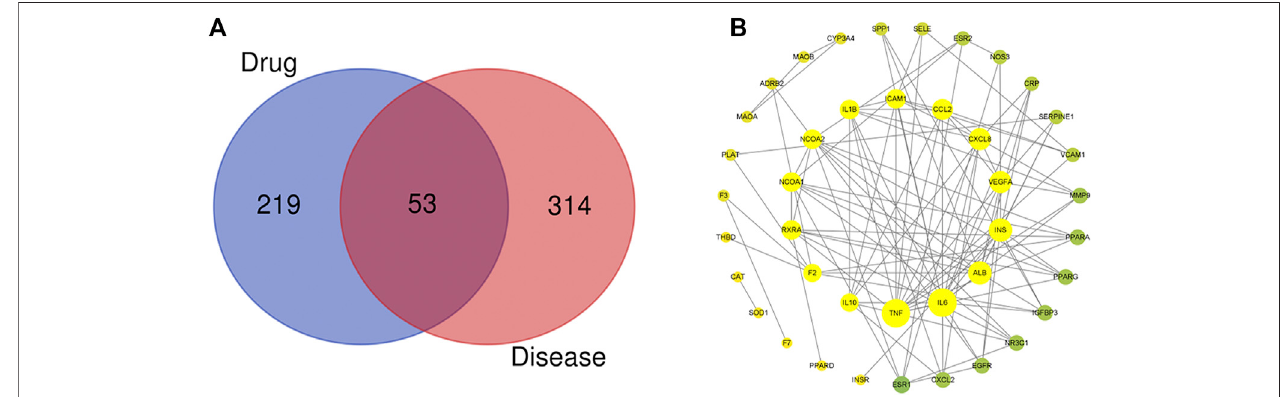
FIGURE 1 | Characteristics of the targets of SEJZ in hyperlipidemia treatment were identi fi ed using network pharmacology. (A) Venn diagram of the common targetsofSEJZinhyperlipidemiatreatment. (B) Theprotein – proteininteraction(PPI)networkisbasedon thetargetsofSEJZ.Nodesrepresent differentproteins. Edges represent the association between proteins. The node size represents the strength of the